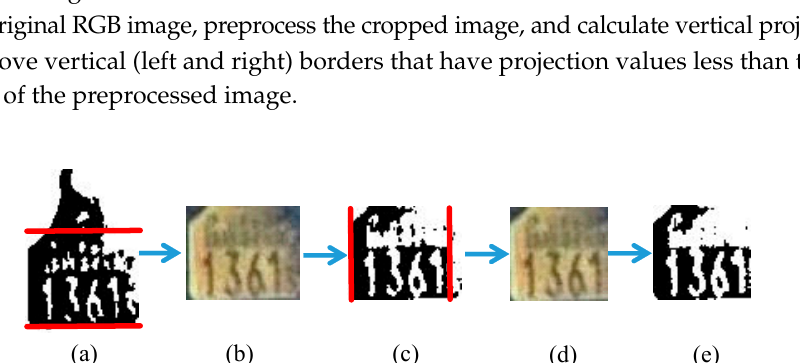
Figure 9. Illustration of step-by-step preprocessing: ( a ) Original Red, Green, and Blue (RGB) image, ( b ) g-scale image, ( c ) inverted image, ( d ) histogram equalized image, and ( e ) binarized image.